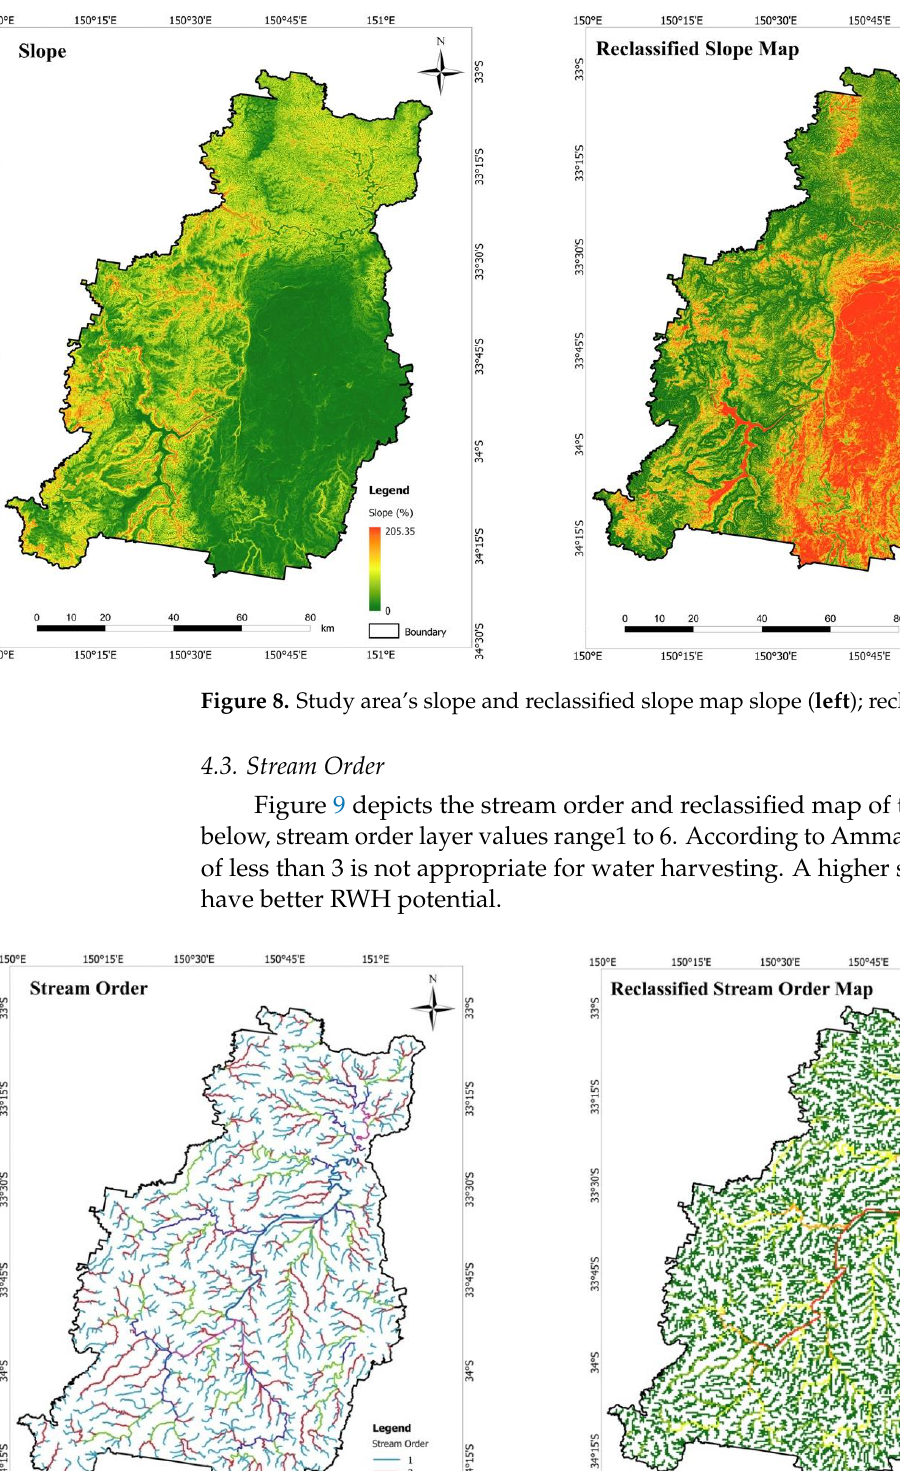
Figure 10. Study area’s drainage density map drainage density ( left ); reclassified drainage density ( right ).